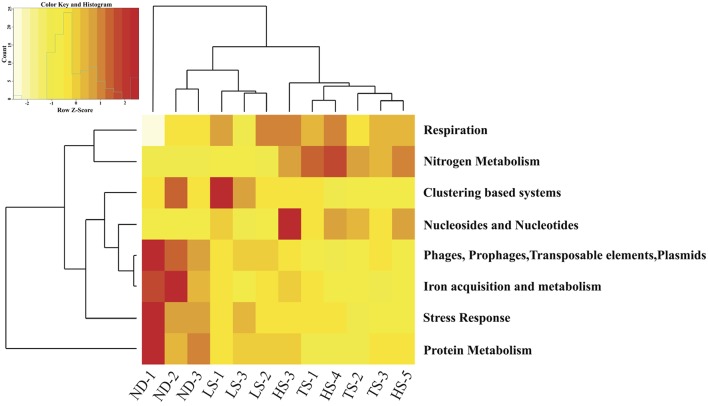
Heat map displaying hierarchical distance clustering of the eight SEED Subsystems differential expressed under HD vs. LD conditions based on normalized transcript abundance. Each row corresponds to a SEED subsystem, and each column to an individual experimental Ifremeria nautilei. Relative expression levels are indicated by colors shown in the scale at the top left. The dendrogram at the top shows the clustering of the individual snail samples. The dendrogram at left demonstrates the clustering of the SEED Subsystems.